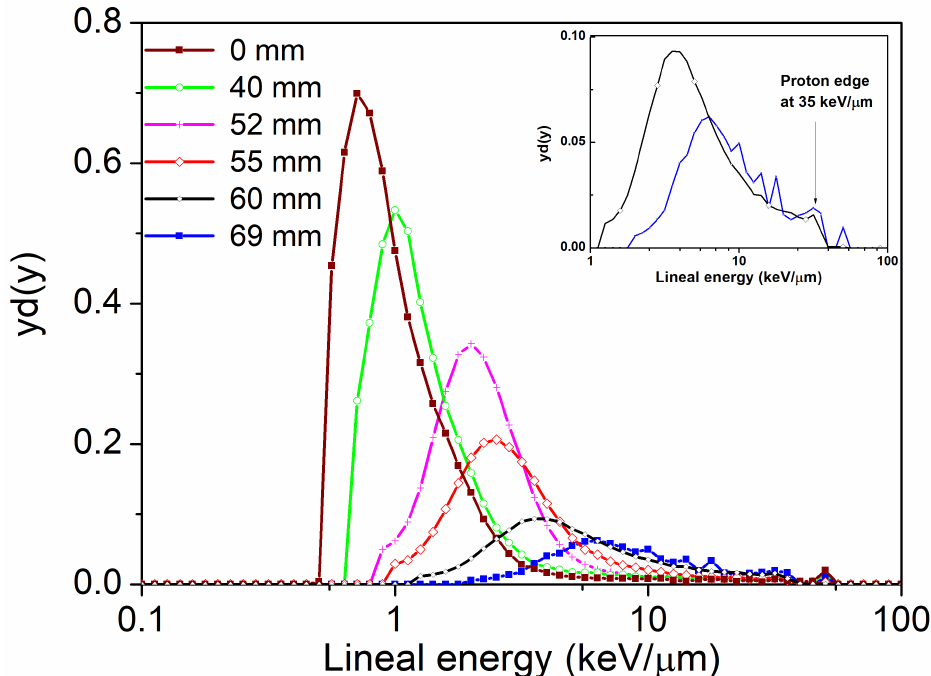
Figure 7. Experimental microdosimetric spectra obtained from a GR diamond microdosimeter in a plastic water phantom at depths of 0, 40, 52, 55, 60 and 69 mm. Inset: a zoom on the spectra at 60 and 69 mm. Proton edge at 35 keV/ µ m corresponds to protons of 1.3 MeV with a stopping range of approximately 12 µ m in diamond equal to the sensor